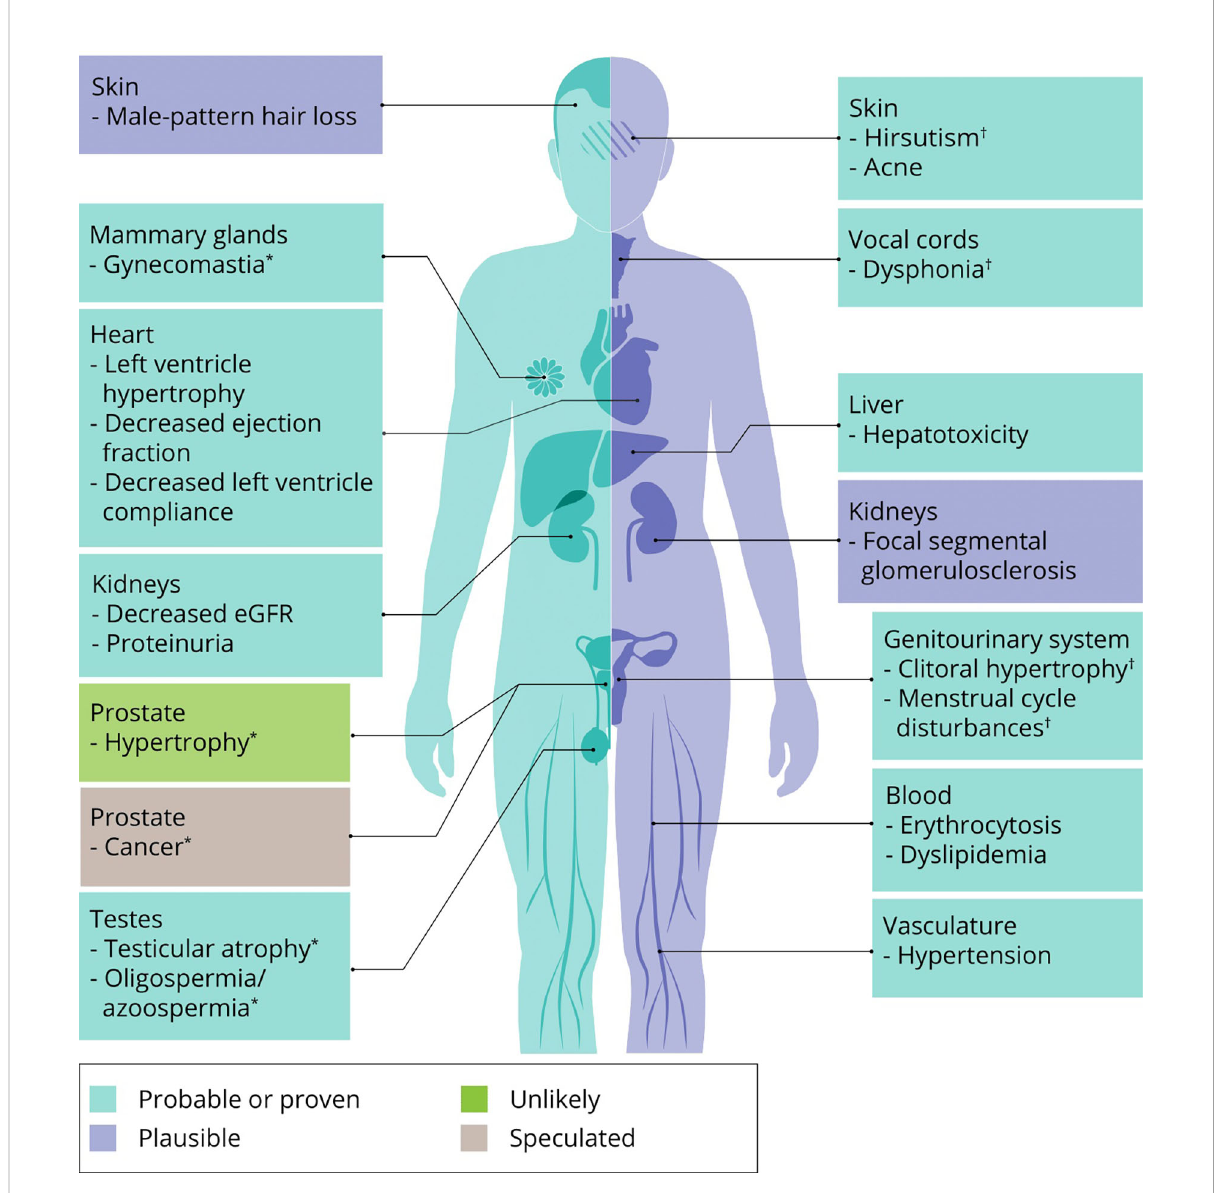
FIGURE 4 An overview of side effects that can be caused by AAS use. Classi fi cation of a side effects ’ probability is based on expert opinion of the authors. ∗ speci fi c to men, † speci fi c to